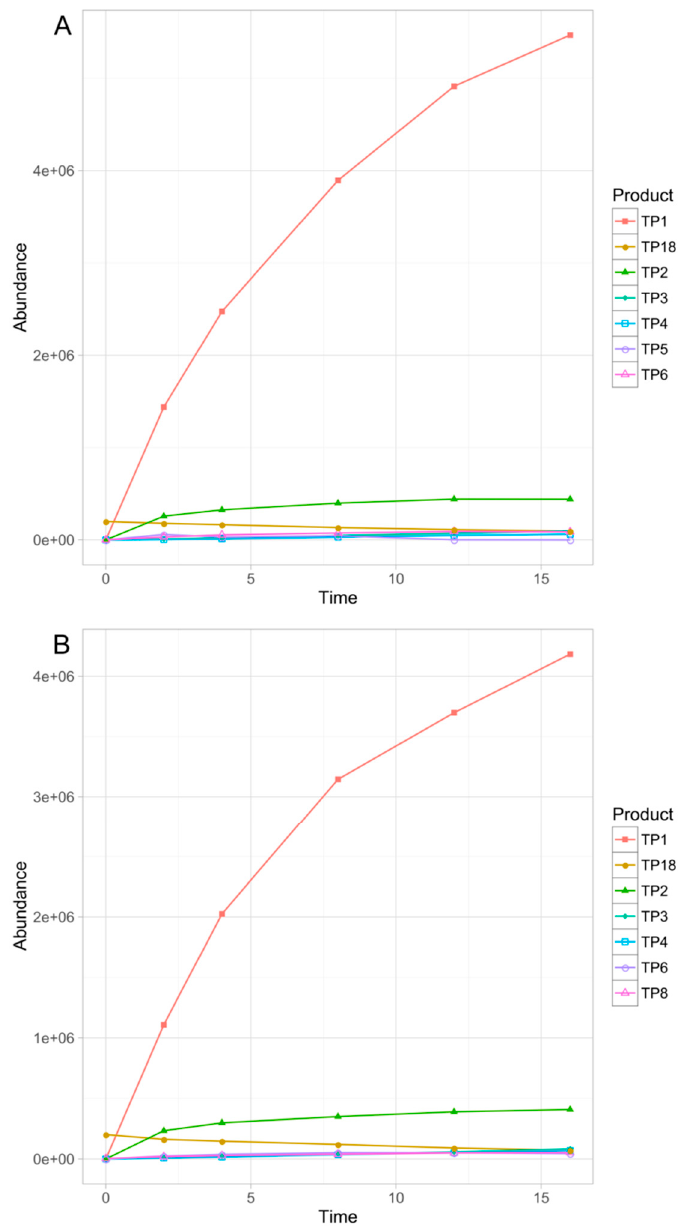
Figure 4. Evolution profiles of the TPs formed in FeOOH ( A ) and Fe 2 O 3 ( B ) photocatalysis.